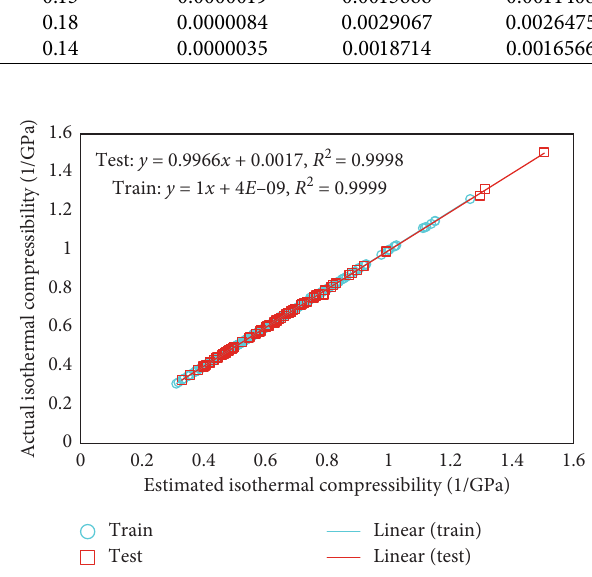
Figure 3: Linear regression for the prediction of isothermal compressibility using the ELM model in the training and testing datasets. Table 2: Comparison of the results of Abooali et al.’s models with the current model in predicting output values at the testing